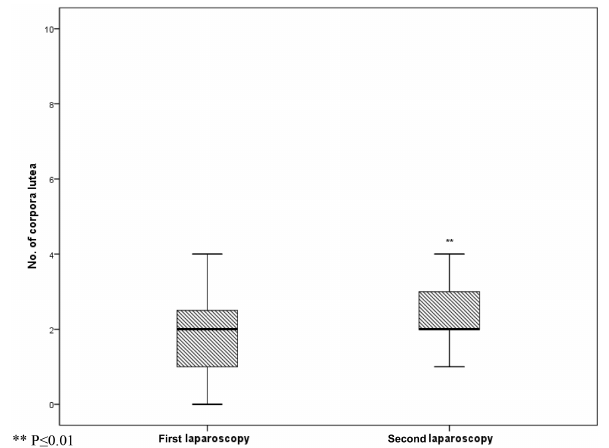
Figure 3. The distribution of corpora lutea of pregnancy in ewes kept in the overhead shelter and in the